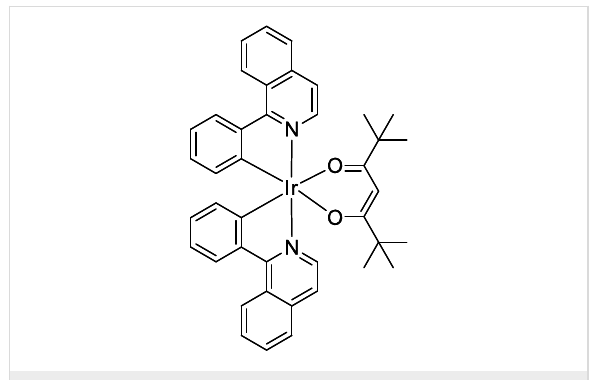
Figure 5: The new proposed PIC (Ir(piq) 2 (tmd)). Indeed, the visible light absorption properties of Ir(piq) 2 (tmd) are much better than those of Ir(ppy) 3 (Figure 6). Remarkably, Ir(piq) 2 (tmd) is perfectly adapted for applications under green light exposure (LED bulb at 514 nm or a laser diode at